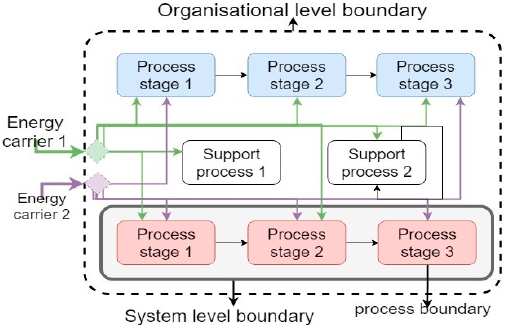
Figure 2. Different boundaries for monitoring energy performance. Figure 2. Di ff erent boundaries for monitoring energy